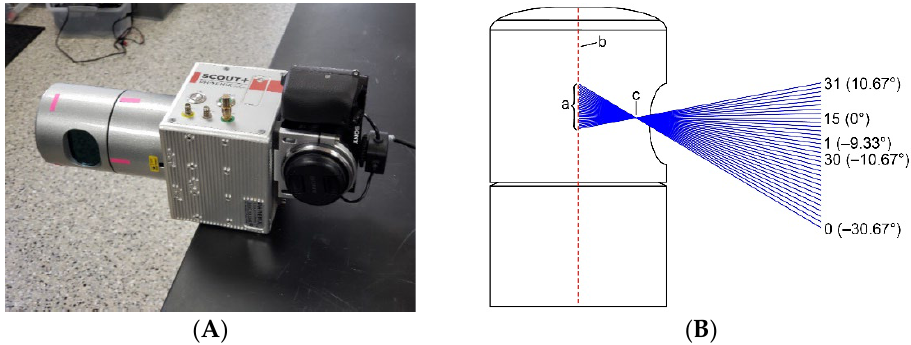
Figure 1. ( A ) Phoenix Lidar Systems ® Scout-32, featuring a Velodyne ® HDL–32E Lidar Scanner and Sony ® Alpha A6000 24 MP camera, with a ( B ) diagram of Velodyne ® HDL–32E, highlighting (a) 32 individual, vertically stacked scanner/receiver pairs that rotate about (b) a central axis oriented through (c) a focal point as they scan a target area. Adapted from [13].